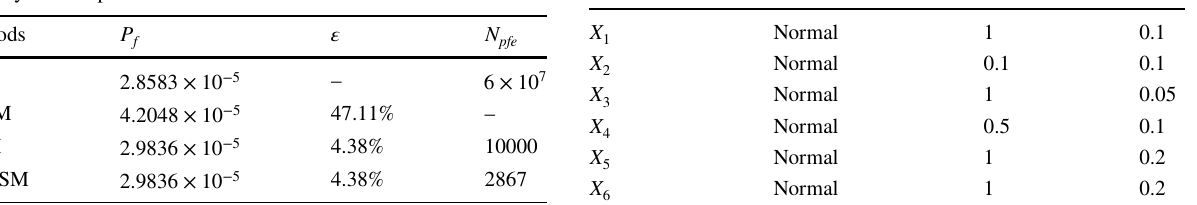
Table 5 Statistical parameters of the random variables in example 3 Random variables